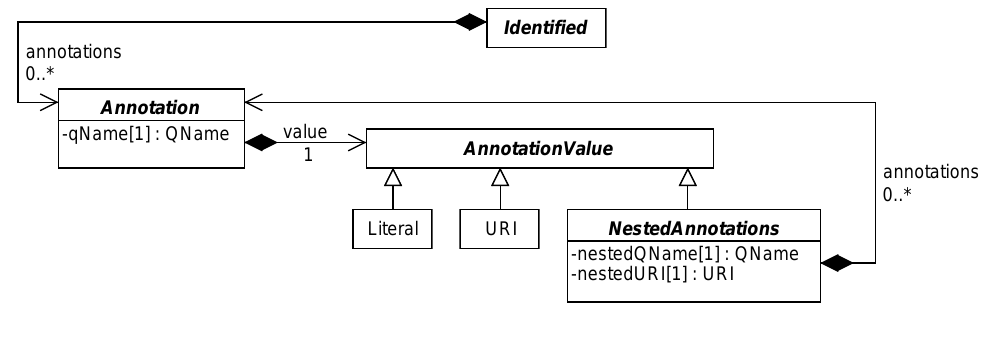
Figure 20: Diagram of the Annotation class and its association with Identified and AnnotationValue objects, which is used for annotating SBOL entities with application specific data.